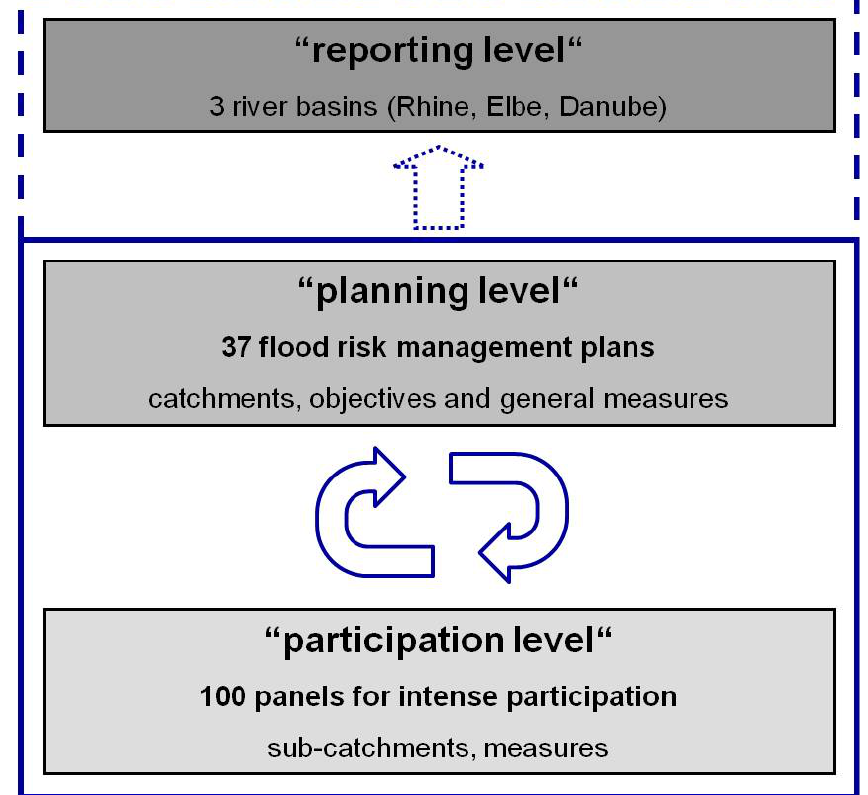
Figure 3. A multi-level concept for the creation of FRM